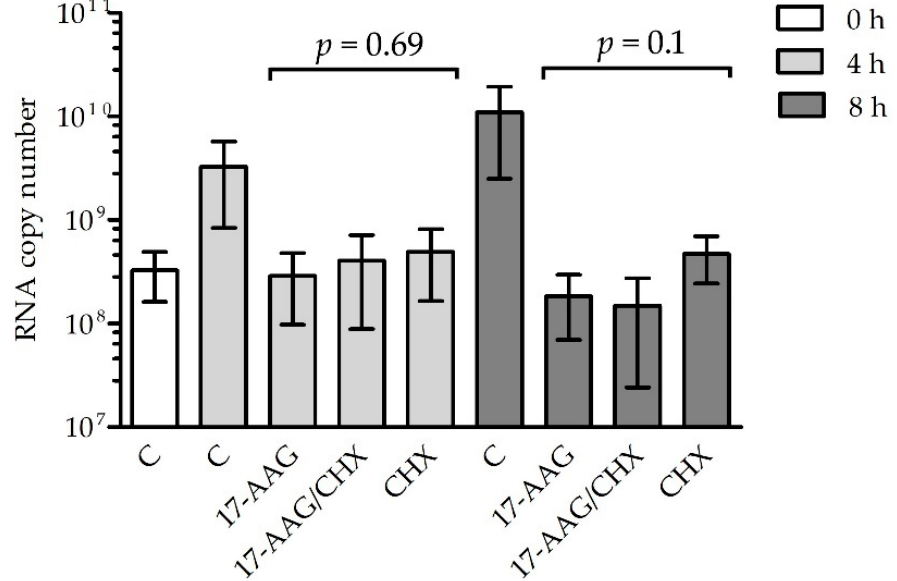
Figure 6. N2a cells were infected with CVS-11 at MOI = 10 for 1 h. The virus was washed off and the cells were incubated for 23 h. At this point, the medium was replaced with fresh medium supplemented with 50 µ g/mL CHX and 1 µ M 17-AAG (0 h), as indicated, and the incubation was continued for 4 or 8 h. The cells cultured in drug-free medium served as the control (C). Viral RNA was measured at the time of the addition of 17-AAG and CHX and after incubation with drugs in total cellular RNA by RT-qPCR and expressed as the number of N gene copies/ µ g of total RNA. The experiment was performed in triplicate. Statistical analysis was performed using one-way